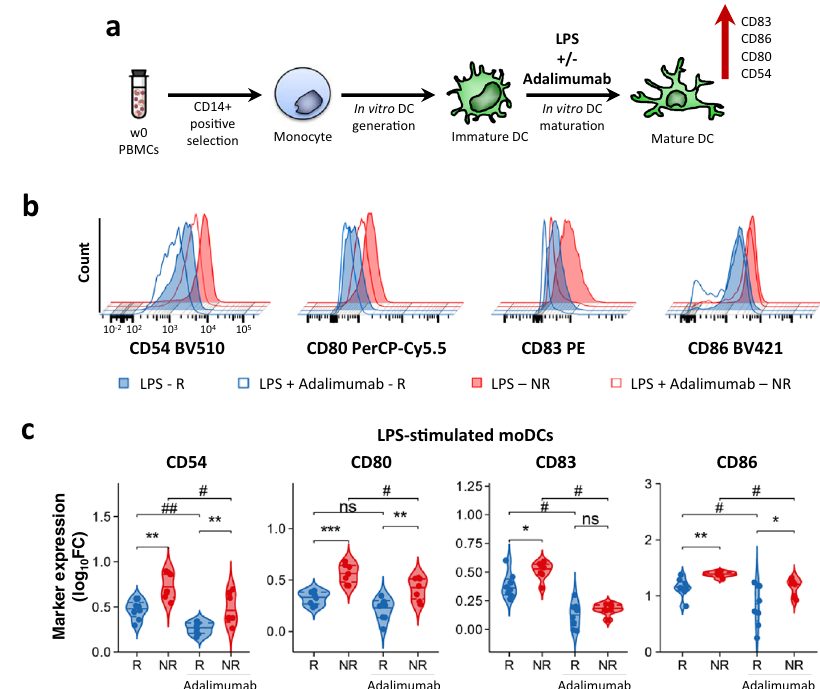
Fig. 3 LPS induces increased moDC maturation in adalimumab non-responders. a moDCs were generated in vitro from monocytes obtained from w0 PBMCs. Maturation was induced by adding LPS in the presence or absence of adalimumab. b Representative fl ow overlay histograms of maturation markers expression in LPS-matured ( fi lled) and LPS + adalimumab (empty) moDCs generated in PASI75 adalimumab responders (R, blue) and non- responders (NR, red). c Violin plot graphs of maturation markers expression (measured as log10FC MFI vs Immature DCs) in PASI-75 adalimumab responders (blue, n = 8) and non-responders (red, n = 7). ( p CD54 RvsNR = 0.0012, RvsNR A = 0.0037; # CD54 = 0.0156, ## CD54 = 0.0078; p CD80 RvsNR = 0.0003, RvsNR A = 0.0037; # CD80 = 0.0156; p CD83 RvsNR = 0.04; # CD83 RvsR-A = 0.0156, NRvsNR-A = 0.0156; p